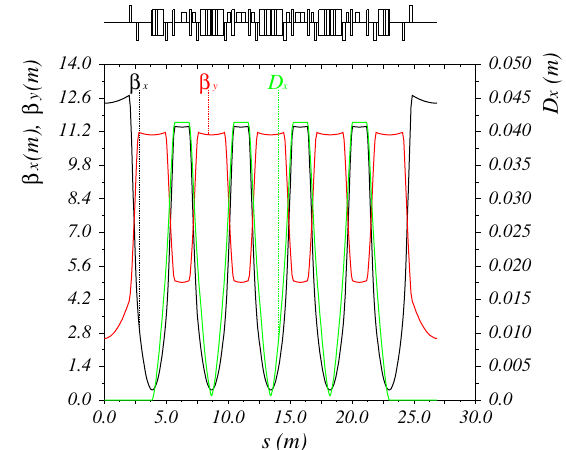
FIG. 28. Superperiod of the light source with 6 GeV beam energy and 33.5 pm emittance.